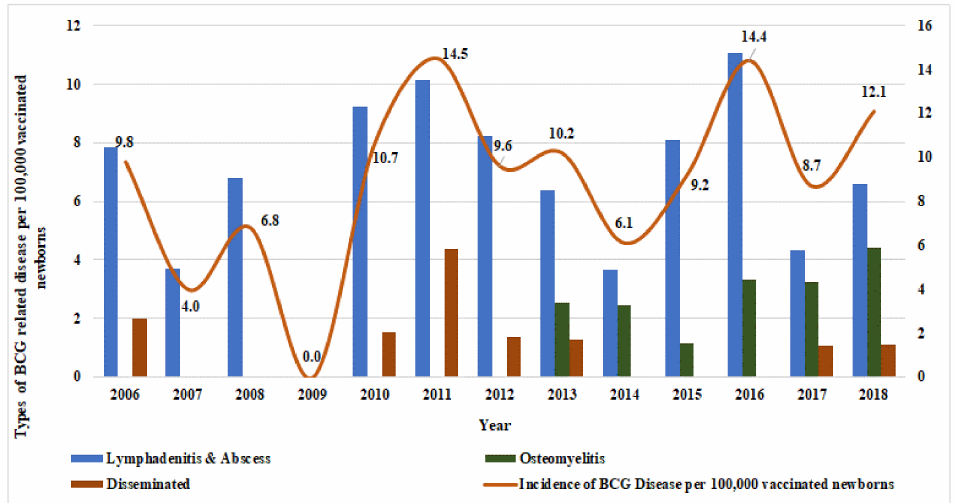
Figure 1. Incidence of total bacille Calmette–Gu é rin (BCG) vaccine-related disease and each type per 100,000 vaccinated